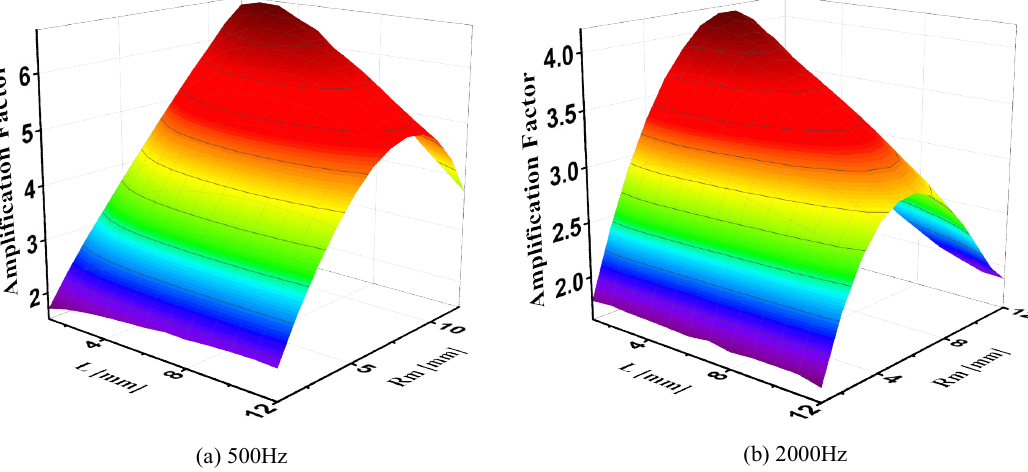
Figure 8. Amplification factor of the DCT horn with different L and Rm at: ( a ) 500 Hz and ( b ) 2000 Hz.